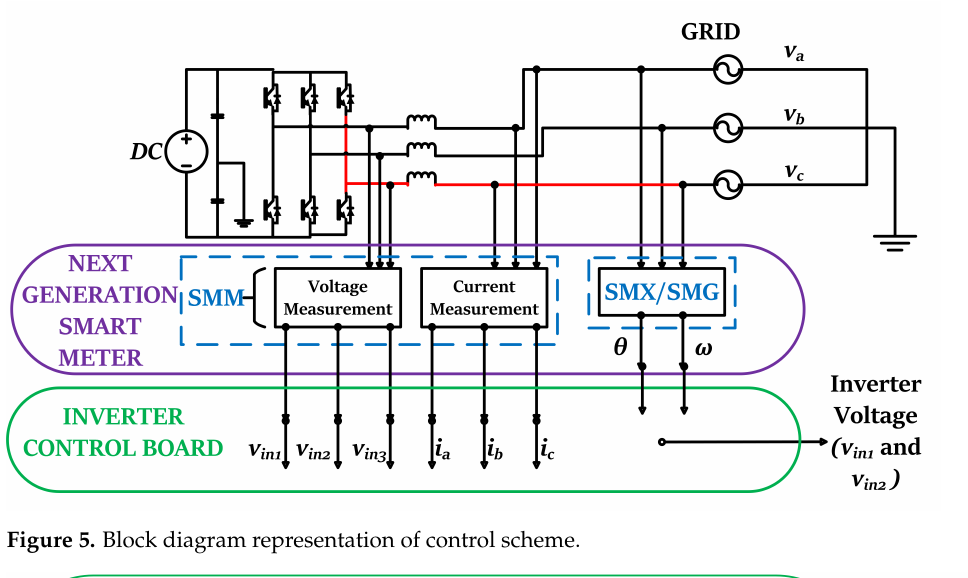
Figure 5. Block diagram representation of control scheme.